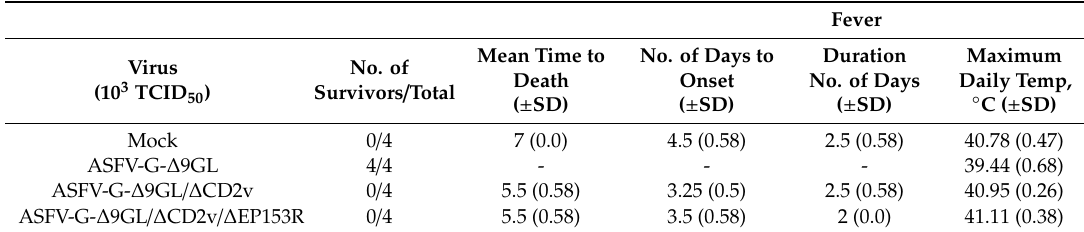
Table 1. Swine survival and fever response following infection with either ASFV-G- ∆ 9GL,